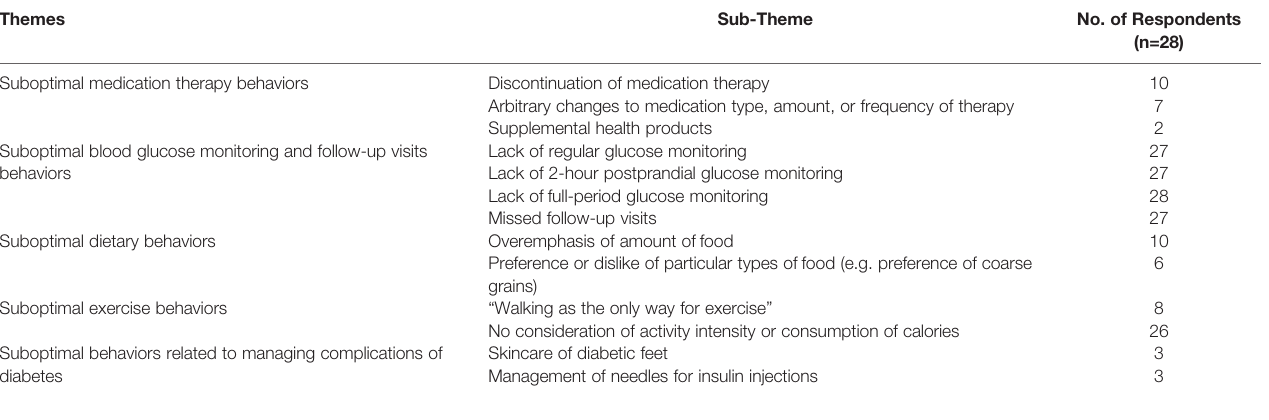
TABLE 1 | Thematic results of suboptimal self-management